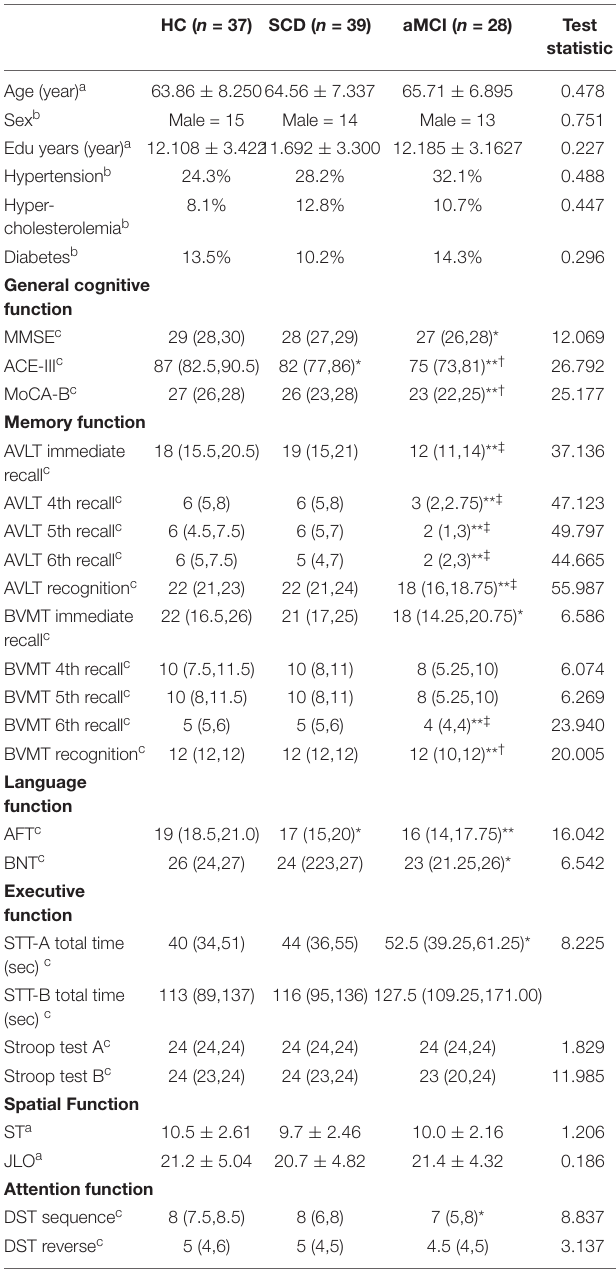
TABLE 1 | Demographic data and neuropsychological tests between